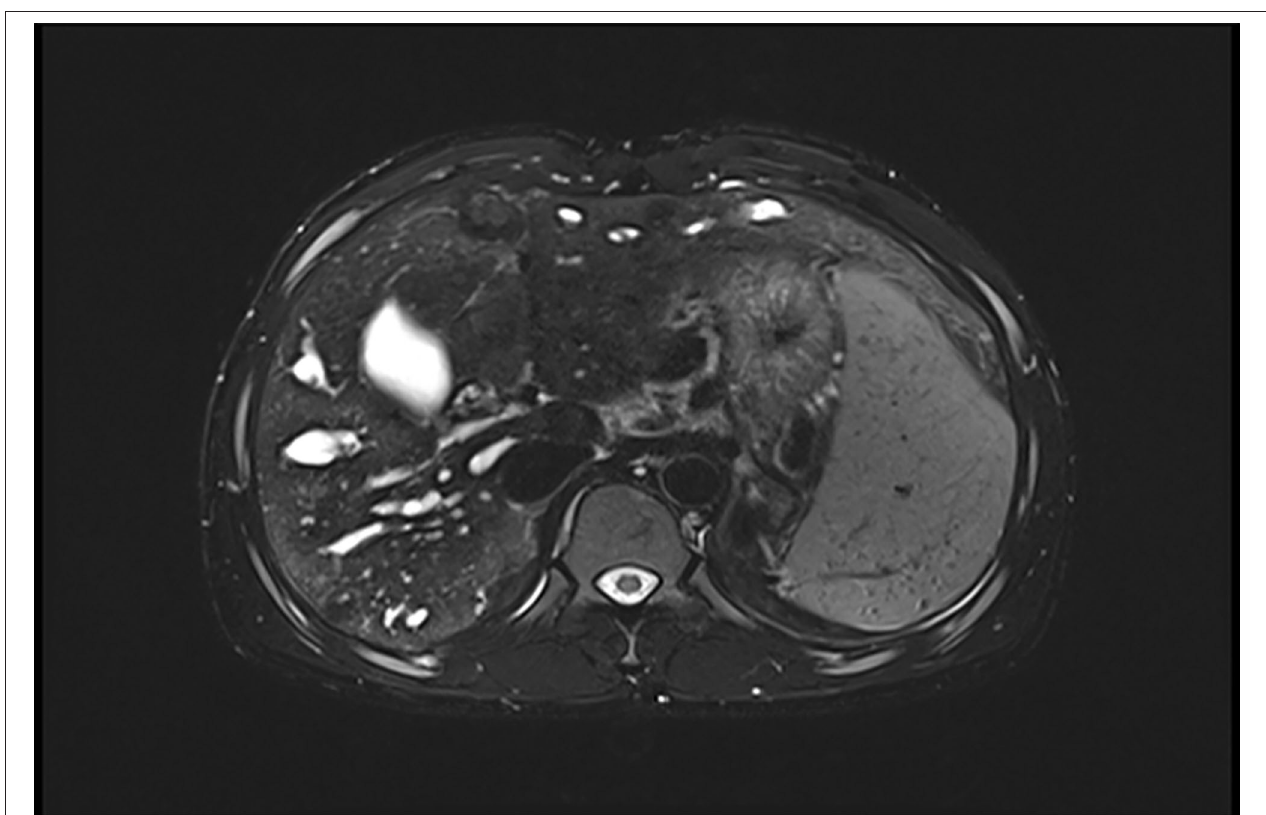
FIGURE 4 | Hepatic MR shows the existence of liver nodule. MR, magnetic